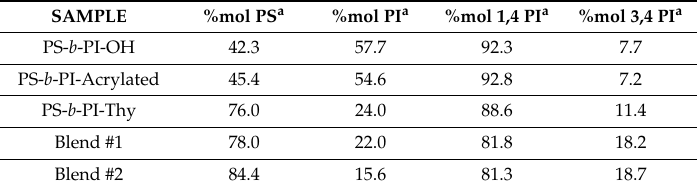
Figure 4. 1 H-NMR spectrum of sample PS- b -PI-Thy. Figure 4. 1 H ‐ NMR spectrum of sample PS ‐ b ‐ PI ‐ Thy. Table 2. PS and PI composition in the modified diblocks and